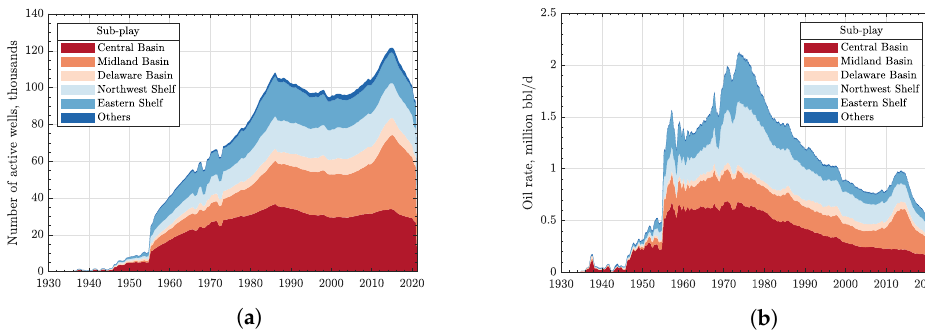
Figure 5. ( a ) Number of active wells and ( b ) total field–daily oil rate colored by